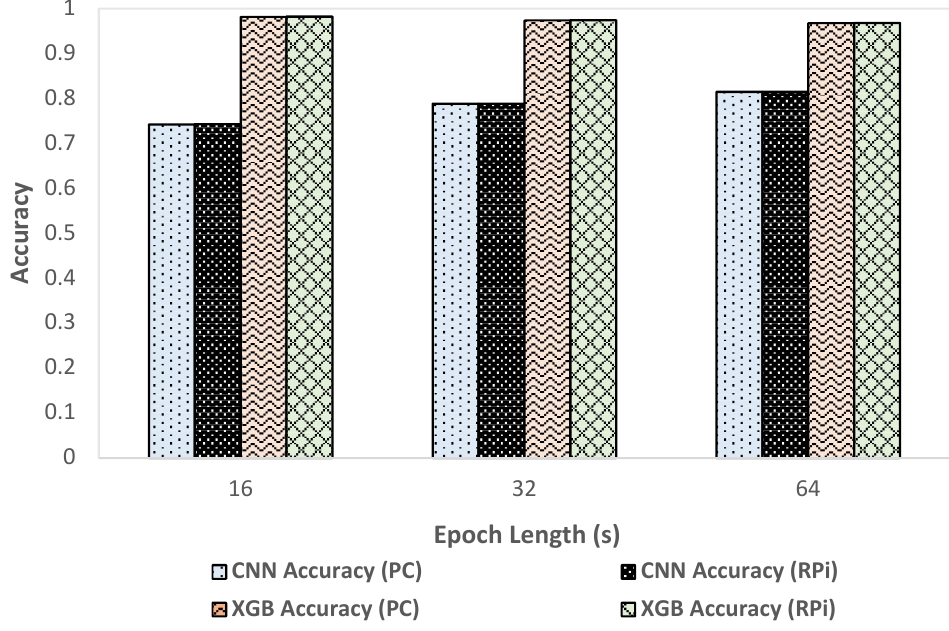
Figure 5. Variation of accuracy with epoch size.